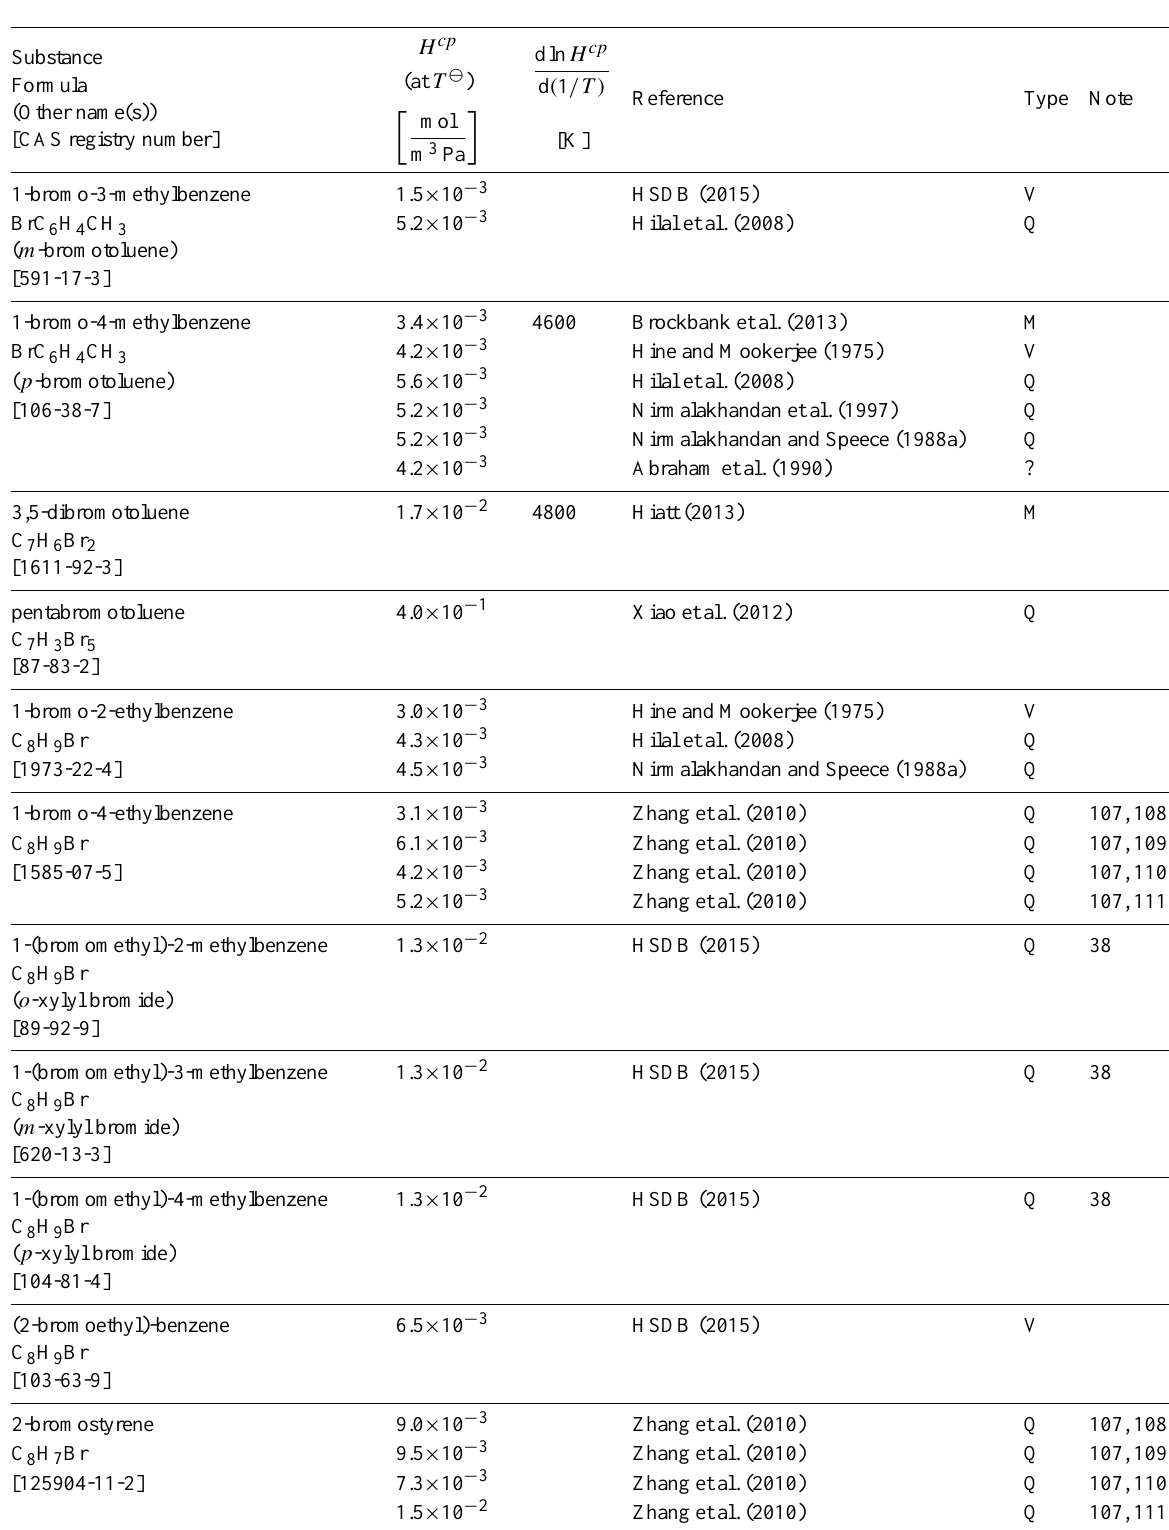
Table 6: Henry’s law constants for water as solvent